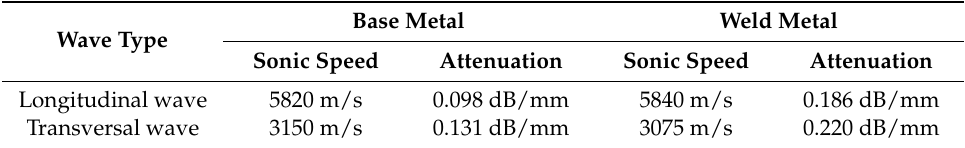
Table 7. Sonic attenuation and sonic speed in the base metal and in the weld